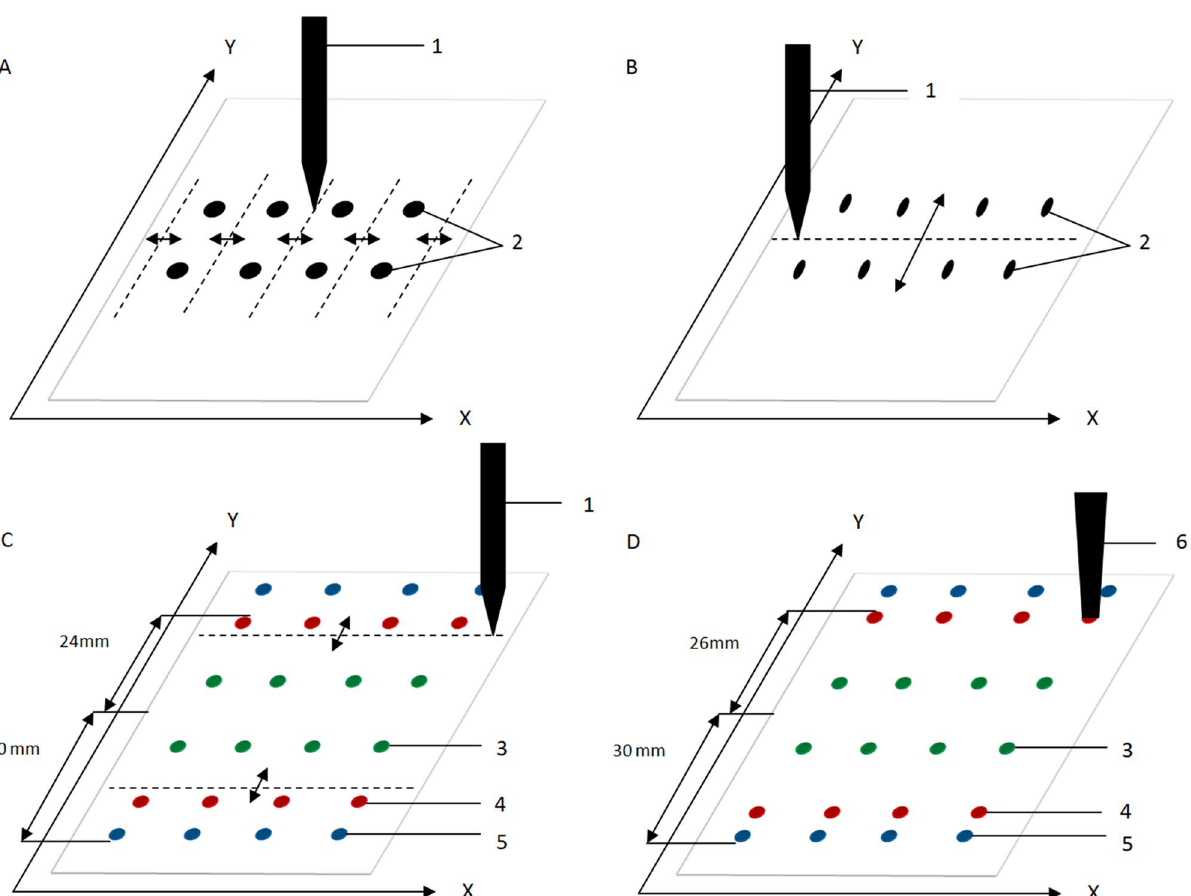
Figure 1. Steps of sample preparation by Solvent Front Position Extraction—explanation in the text. The dashed lines mark the path of the pipette delivering the eluent, the arrows indicate the directions of the